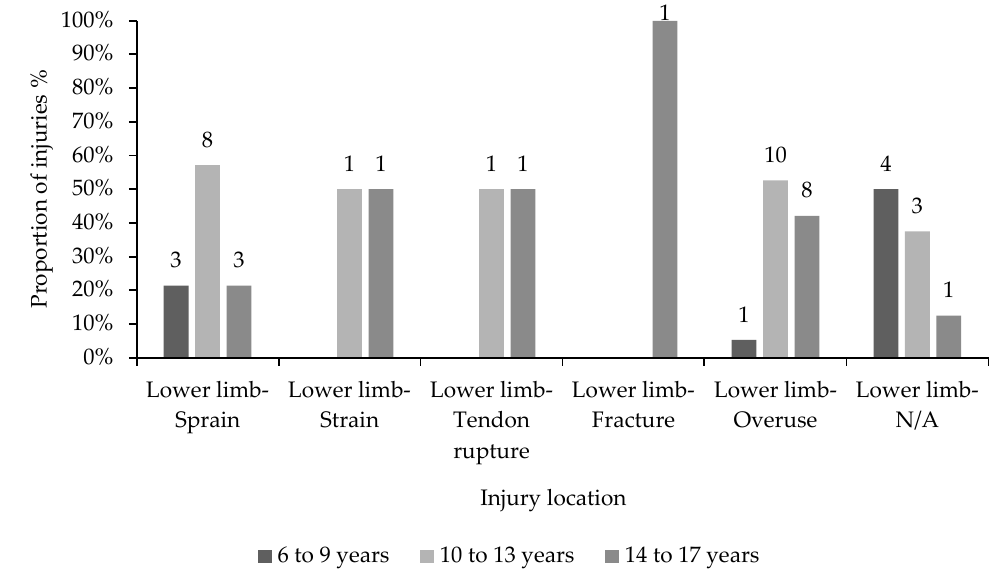
Figure 2. Proportions of diagnosed lower limb injury types distributed across three age categories.